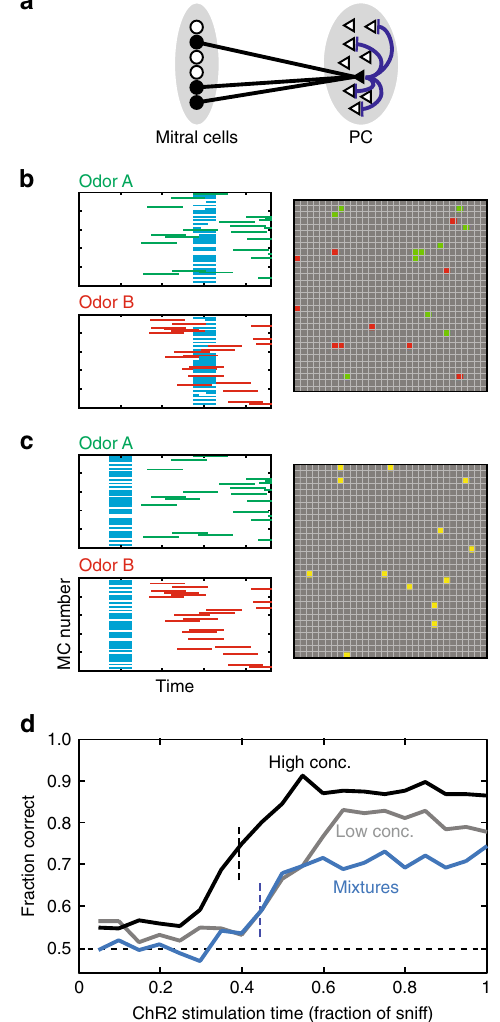
Fig. 5 Computational model of primacy decoder can explain behavioral effects of mask. a The schematic of the network included in the computational model. Pyramidal neurons in PC receive random excitatory connections from MT cells (black lines) and connected to a random subset of other pyramidal neurons via inhibitory connections (blue lines). The inhibitory connections are responsible for blocking of the inputs to PC after the initial (primary) representation is formed. b , c Responses of MCs (100 out of 300) and PC cells for late ( b ) and early ( c ) masks. MCs respond to Odor A, Odor B, and ChR2 (green, red, cyan). PC responses at the end of sniff cycle (gray squares) are shown for two odors in the same panel. For the early mask ( c ), PC responses are indistinguishable for two smells (yellow). d Discrimination success rate as a function of mask latency for three conditions: odors A vs. B — high concentrations (black line), odors A vs. B – low concentrations (gray line), odor mixtures 60% A + 40% B vs. 40% A + 60% B (blue line). Low/high concentration conditions were introduced by expanding/compressing the timing of MC odorant-related inputs within the sniff cycle. Mixtures were introduced by combining together high conc. sequences of inputs corresponding to odors A and B. The temporal dependencies reproduce the basic qualitative features of data (Fig. 2b, e), including concentration-dependence of the error rate at different ChR2